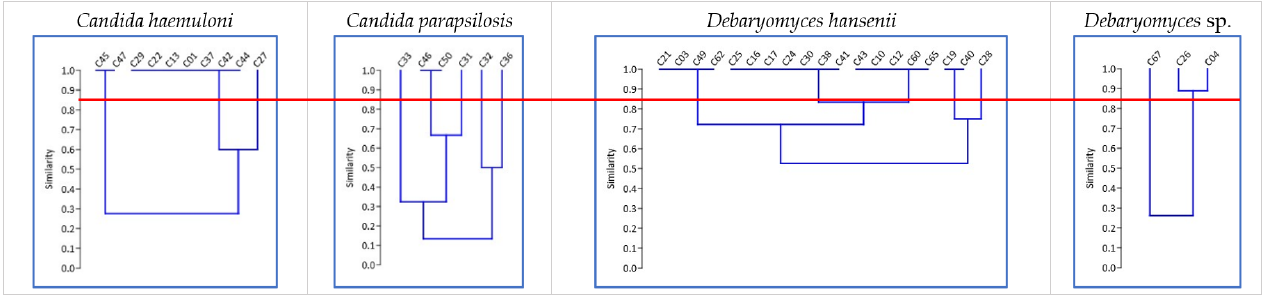
Figure 1. Dendrograms obtained from the RAPD-PCR of each yeast species by the UPGMA method (Jaccard distance). The red line shows a similarity level of 85%. Table 2. RAPD-PCR profiles and biomass production of yeast isolates. Yeasts marked with ✓ were selected. The results are presented as the mean ± standard error.